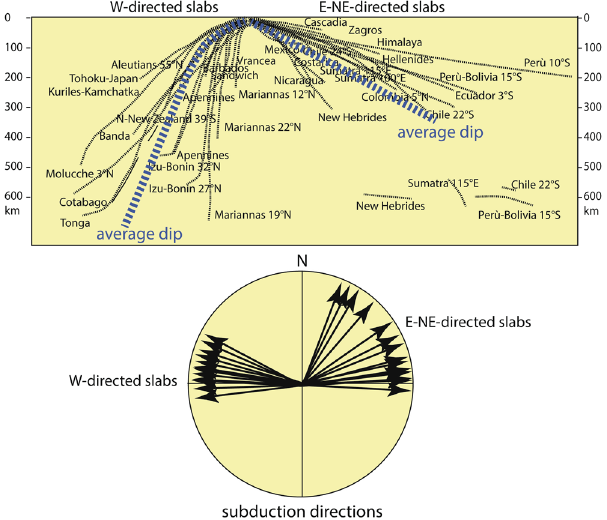
Figure 1. Slab dip of the main subduction zones of the world measured parallel to the convergence direction among upper and lower plates. Subduction directions appear concentrated into two main trends, i.e., W-ward and E-ward or N-NE-ward. W-directed subduction zones are steeper than E- or NE-ward directed subduction